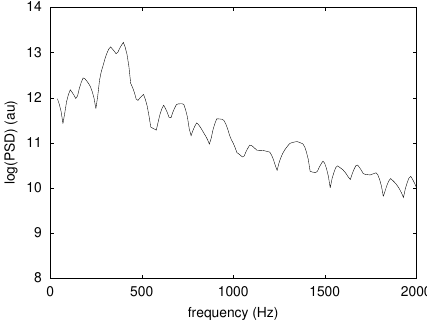
Figure 7. Power spectral density (PSD) of pressure.